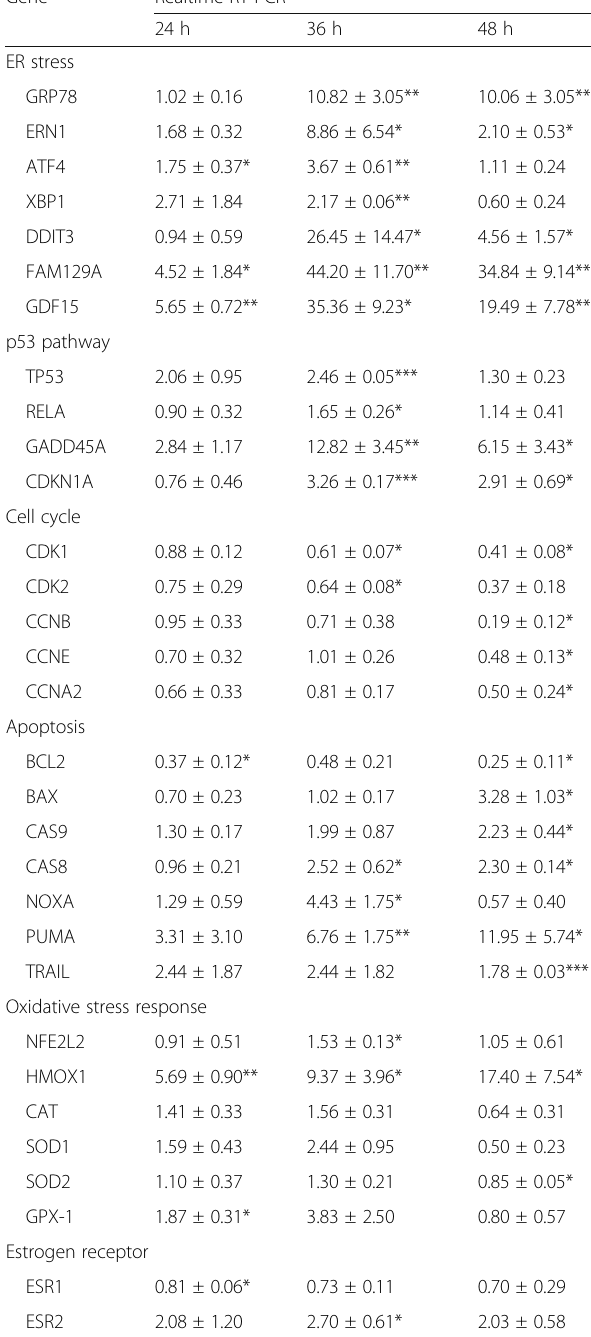
Table 5 Real-time RT-PCR analysis of gene expression level after treating MCF-7 cells with NDL for 24, 36 and 48